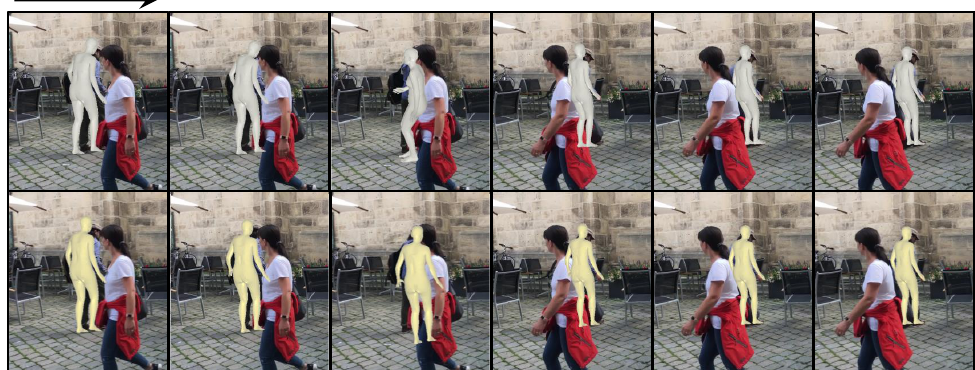
Figure 1. This figure shows a 3D human mesh sequence estimated by VIBE ( top row ) and its refined result by our proposed method ( bottom row ). In the 3rd frame, VIBE fails to estimate the correct pose of the target person due to severe occlusion. Our method effectively refines the incorrectly estimated